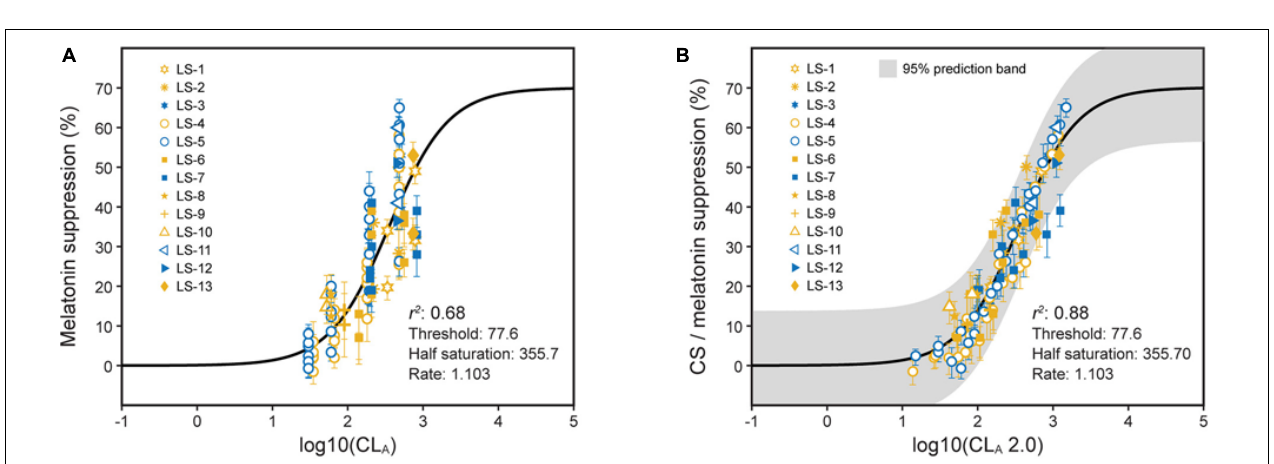
FIGURE 7 | The spectral sensitivities to narrowband light sources from Brainard et al. (2001) (open circles) and Thapan et al. (2001) (solid diamonds) along with predictions from the 2005 (Rea et al., 2005, 2012; Rea and Figueiro, 2018) (A) and revised (B) CS models (dashed lines).